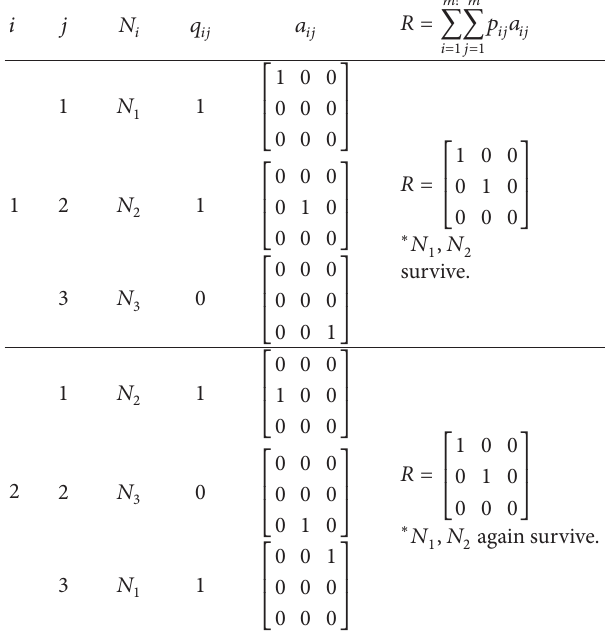
Table 1: Calculation for maximizing number of 𝑅